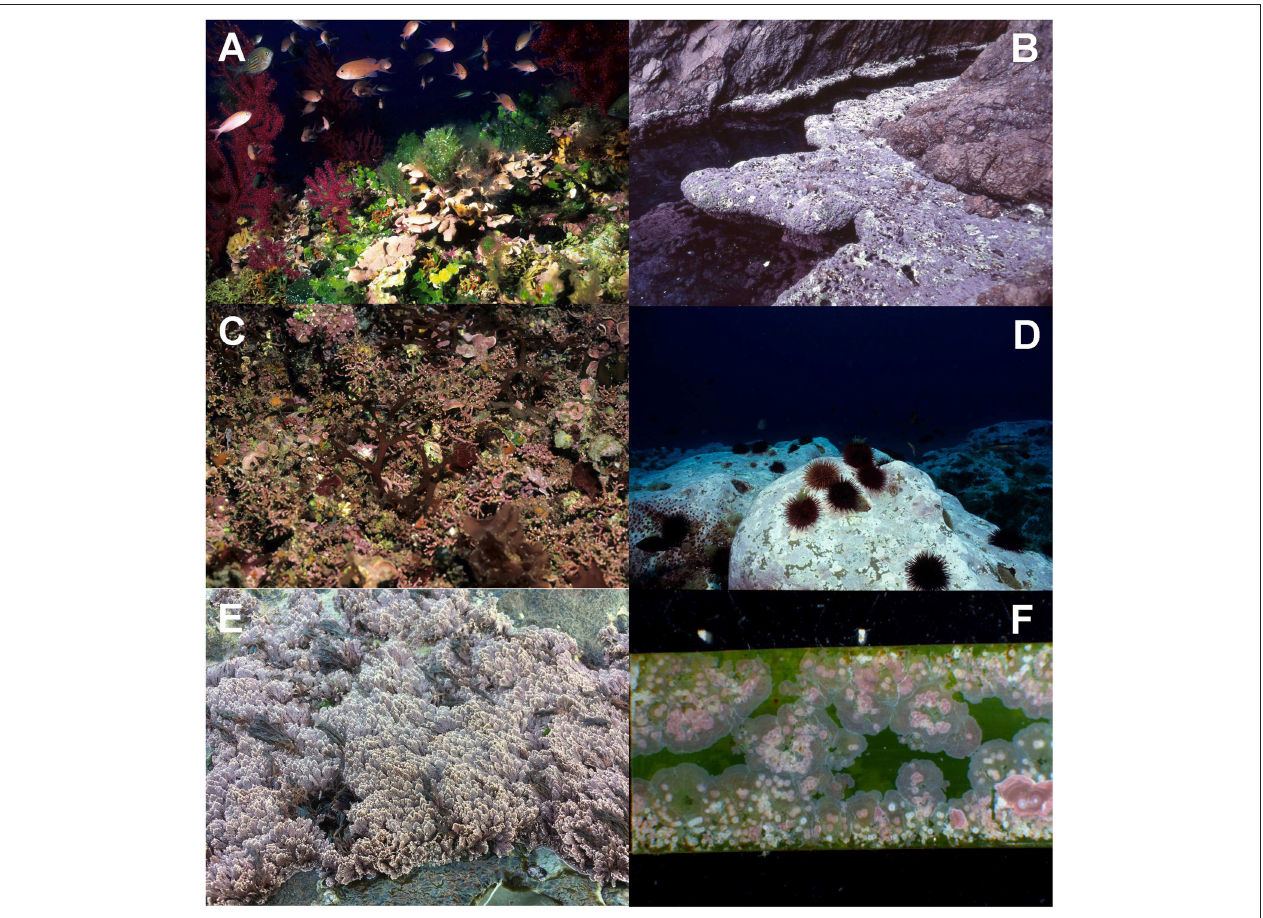
FIGURE 1 | Examples of coralline-dominated habitats in the Mediterranean. (A) A coralligenous community (Islas Columbretes, Spain); copyright: Enric Ballesteros (kike@ceab.csic.es). (B) A Lithophyllum byssoides rim (Cala Litizia, Scandola Nature Reserve, Corsica, France); copyright: Marc Verlaque (marc.verlaque@ mio.osupytheas.fr). (C) Detail of a maerl bed (Islas Columbretes, Spain); copyright: Enric Ballesteros (kike@ceab.csic.es). (D) A barren ground dominated by encrusting corallines on a bottom heavily grazed by sea urchins (Alboran Island, Spain); copyright: Enric Ballesteros (kike@ceab.csic.es). (E) An intertidal rim of articulated corallines (Passetto di Ancona, Italy). (F) Detail of a leaf of the seagrass Posidonia oceanica covered by epiphytic encrusting corallines (Ischia Island, Italy); copyright: Maria Cristina Gambi (gambimc@gmail.com). All pictures were provided by the copyright owners and reproduced with their permission.